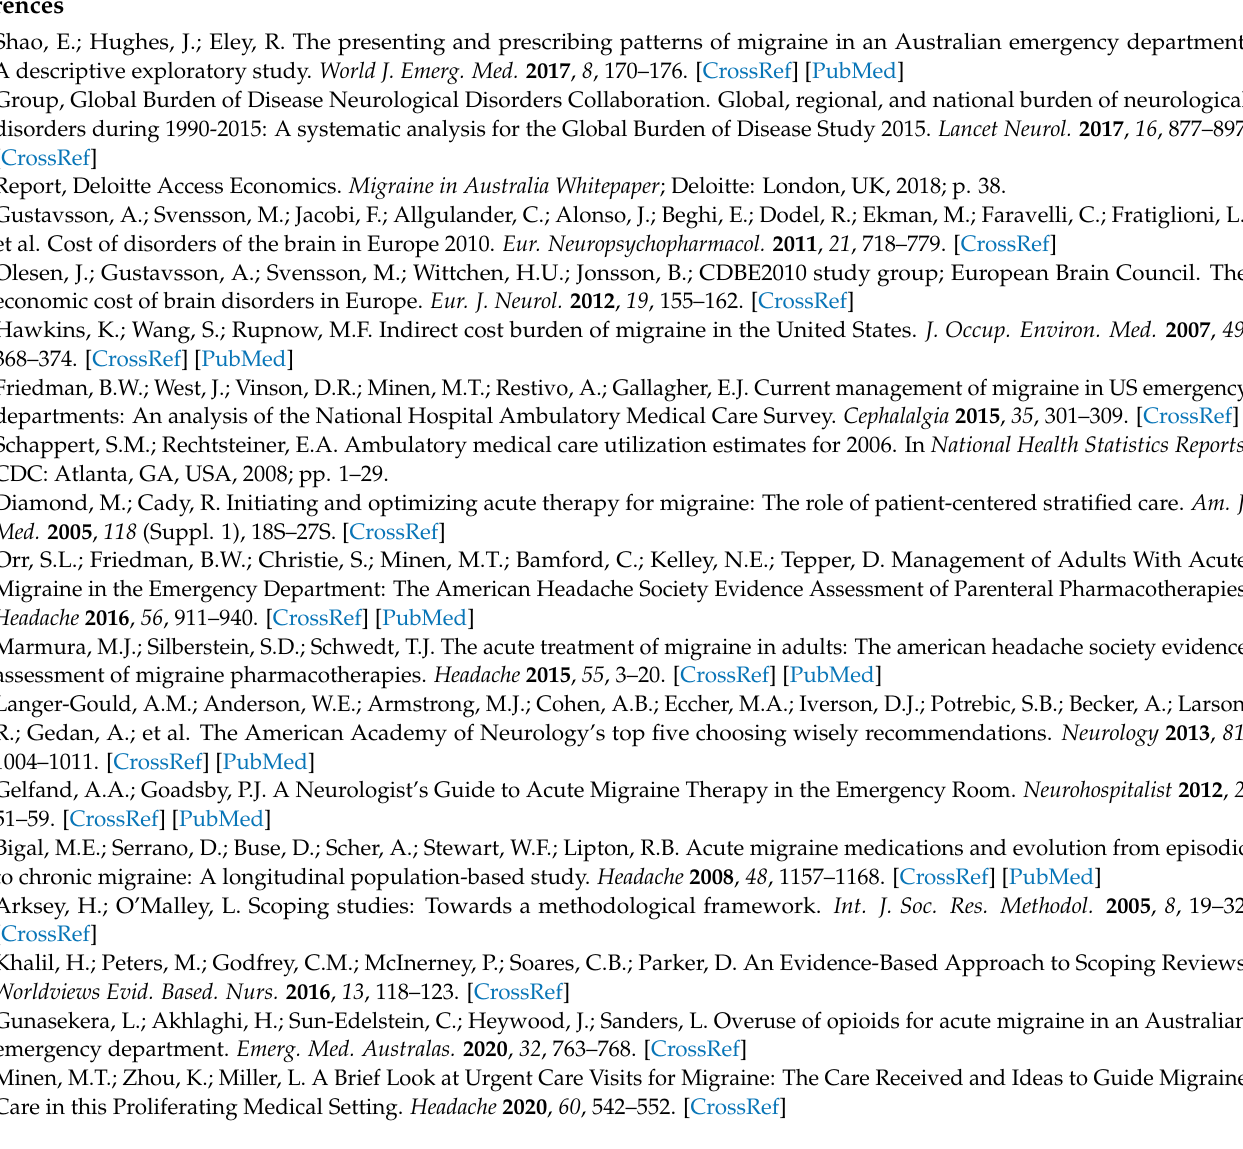
Table S3: Summary of excluded